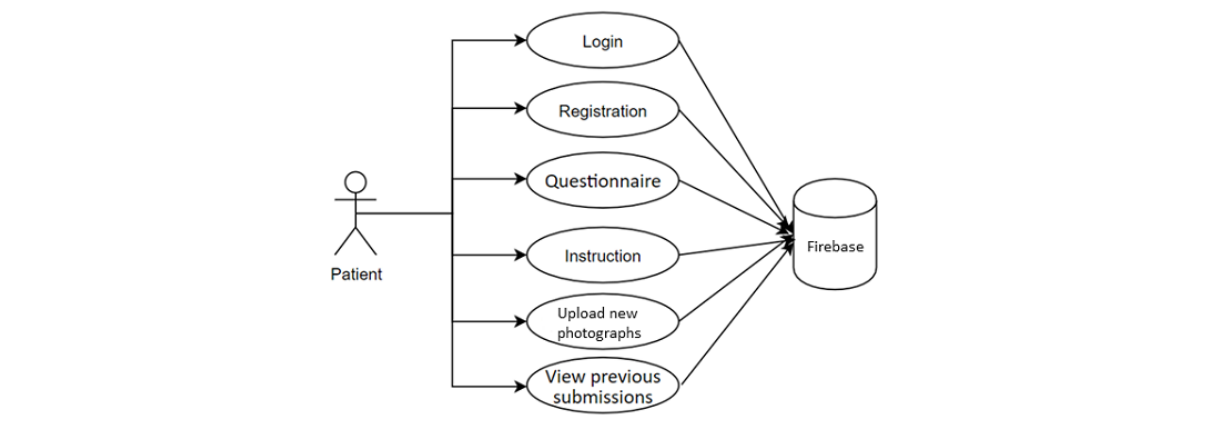
Figure 2. Patient use